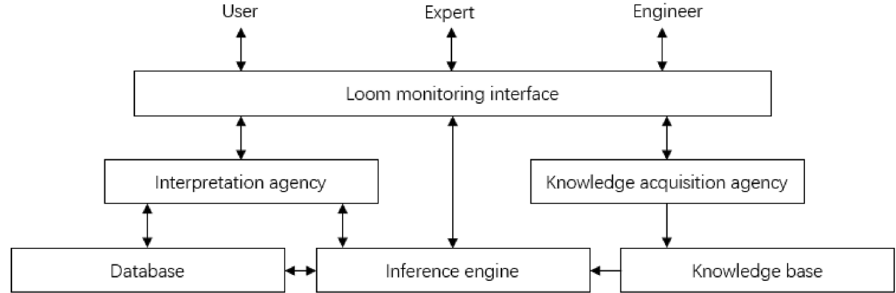
Fig. 6 Logic diagram of fault tree diagnosis